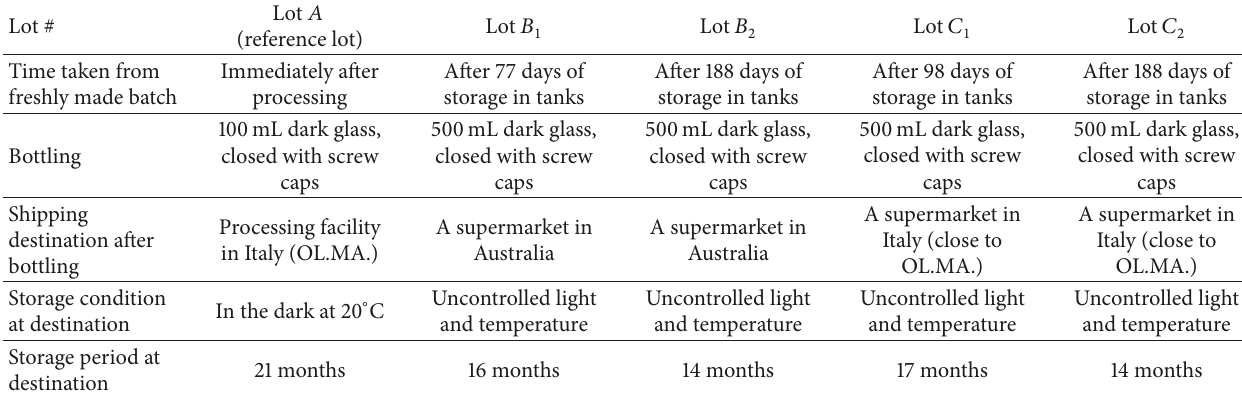
Table 3: Sample Lot information in the Pagliarini et al. (2000) model.